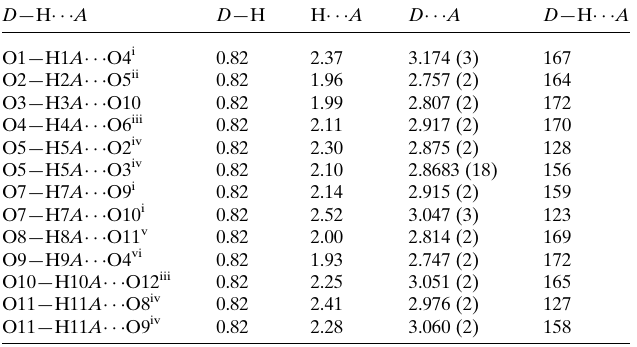
Table 1 Hydrogen-bond geometry (A˚ , (cid:4) ).